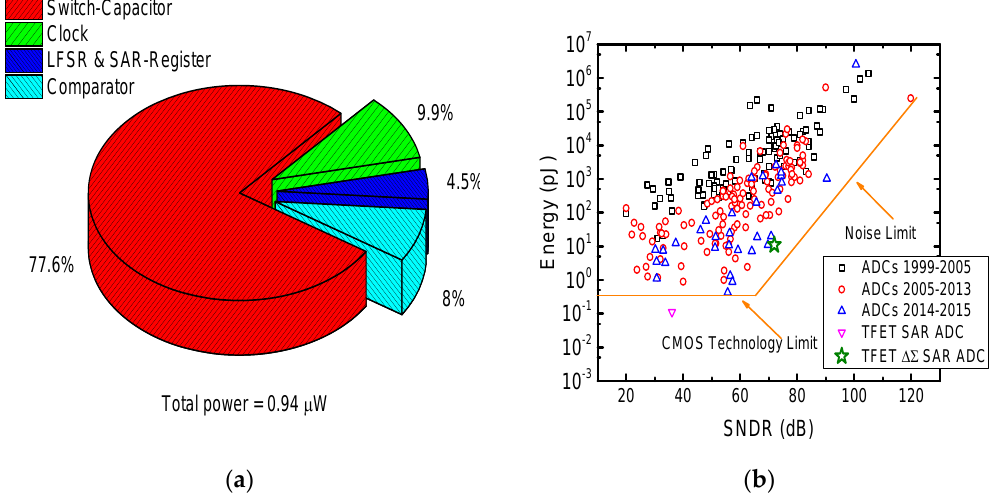
Figure 27. ( a ) Power distribution diagram; ( b ) Energy versus signal noise dynamic range.